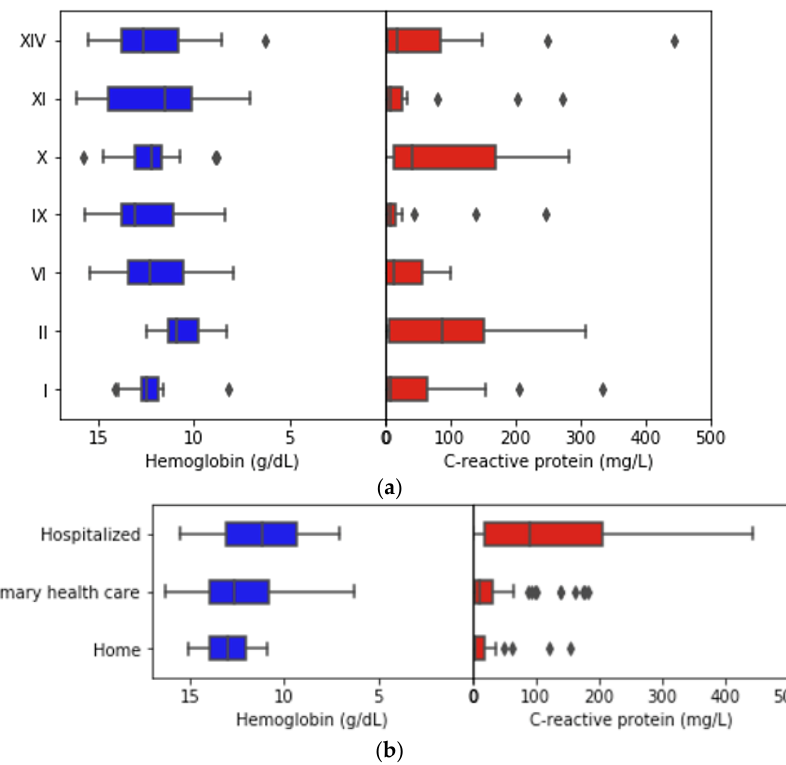
Figure 2. Boxplots show the distribution of hemoglobin and c-reactive protein according to diagnostics group ( a ) and type of discharge ( b ). Rectangles represent the second and third quartiles with a vertical line inside to indicate the median value. The lower and upper quartiles are shown as horizontal lines on either side of the rectangle and outliers are plotted outside of it, individually.